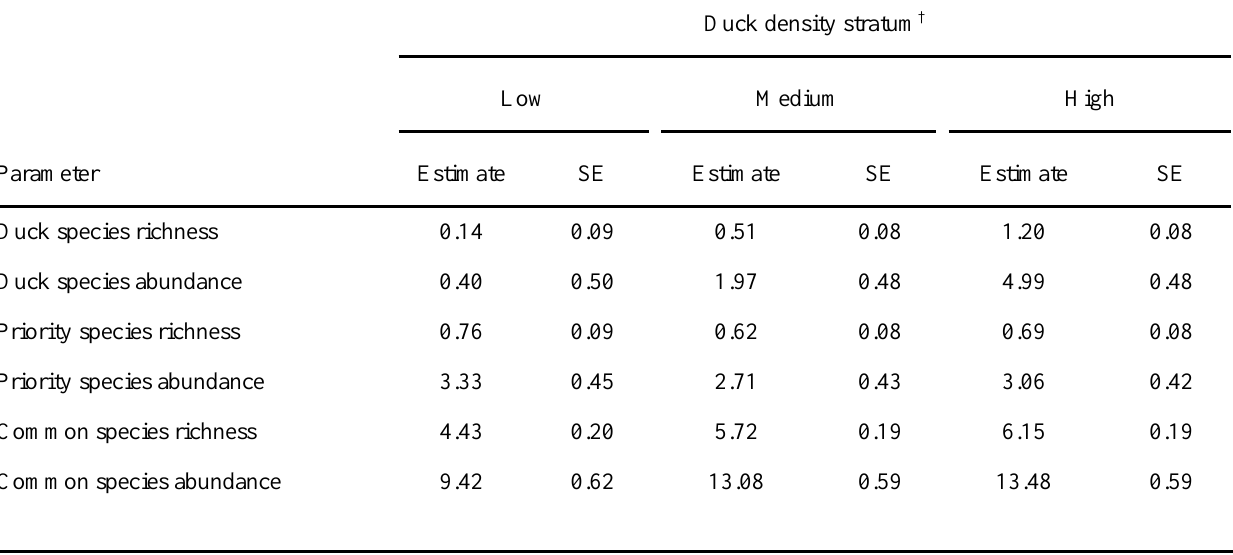
Table 2. Parameter estimates and SEs derived from linear mixed models for the species richness and abundance of three key grassland bird groups encountered at point count stations along transects in southern Saskatchewan in 2001 and